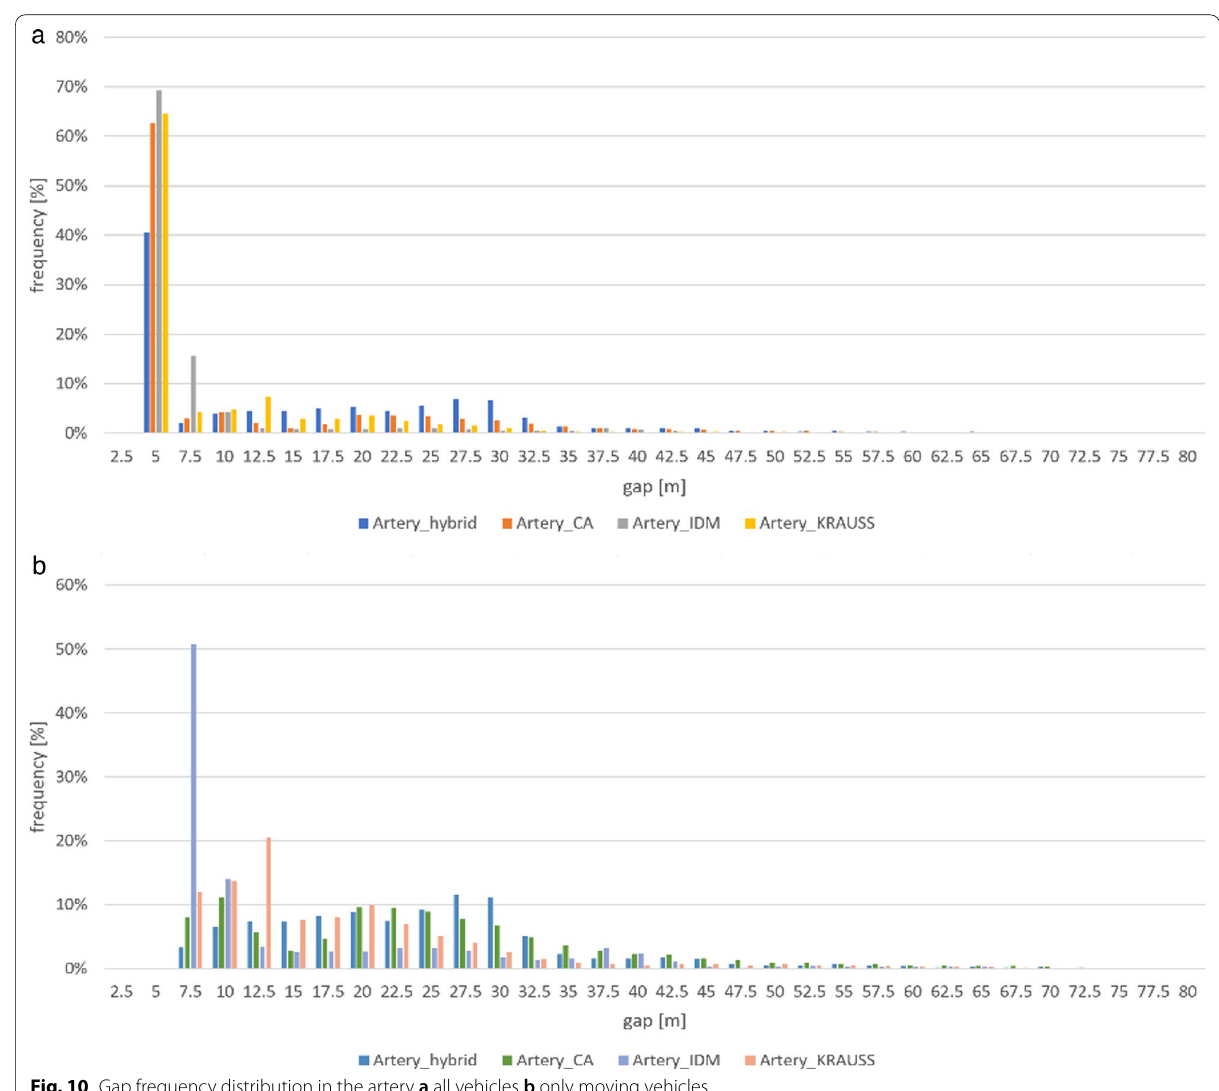
Fig. 10 Gap frequency distribution in the artery a all vehicles b only moving vehicles